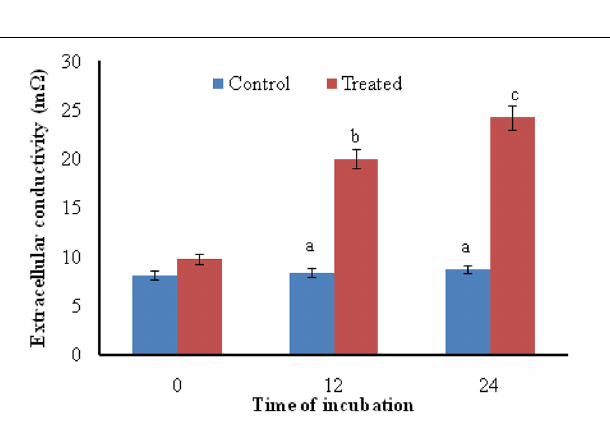
FIGURE 2 | Effect of antifungal metabolites on extracellular conductivity in suspension of test fungi ( A. brassicicola ) after 0, 12, and 24 h of treatment; Columns and bars represent the mean ± SD. Same letters on the bar are not significantly different according to Tukey’s test (p ≤